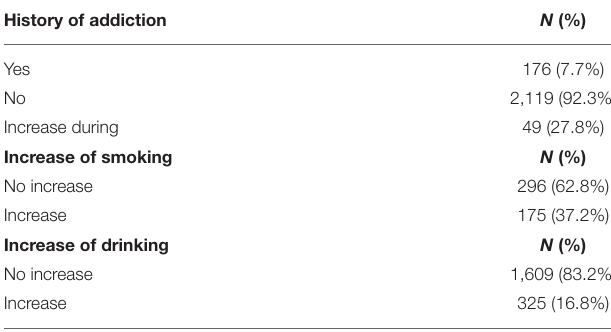
TABLE 2 | Rate of addiction, an increase of smoking and drinking ( N = 2,295).